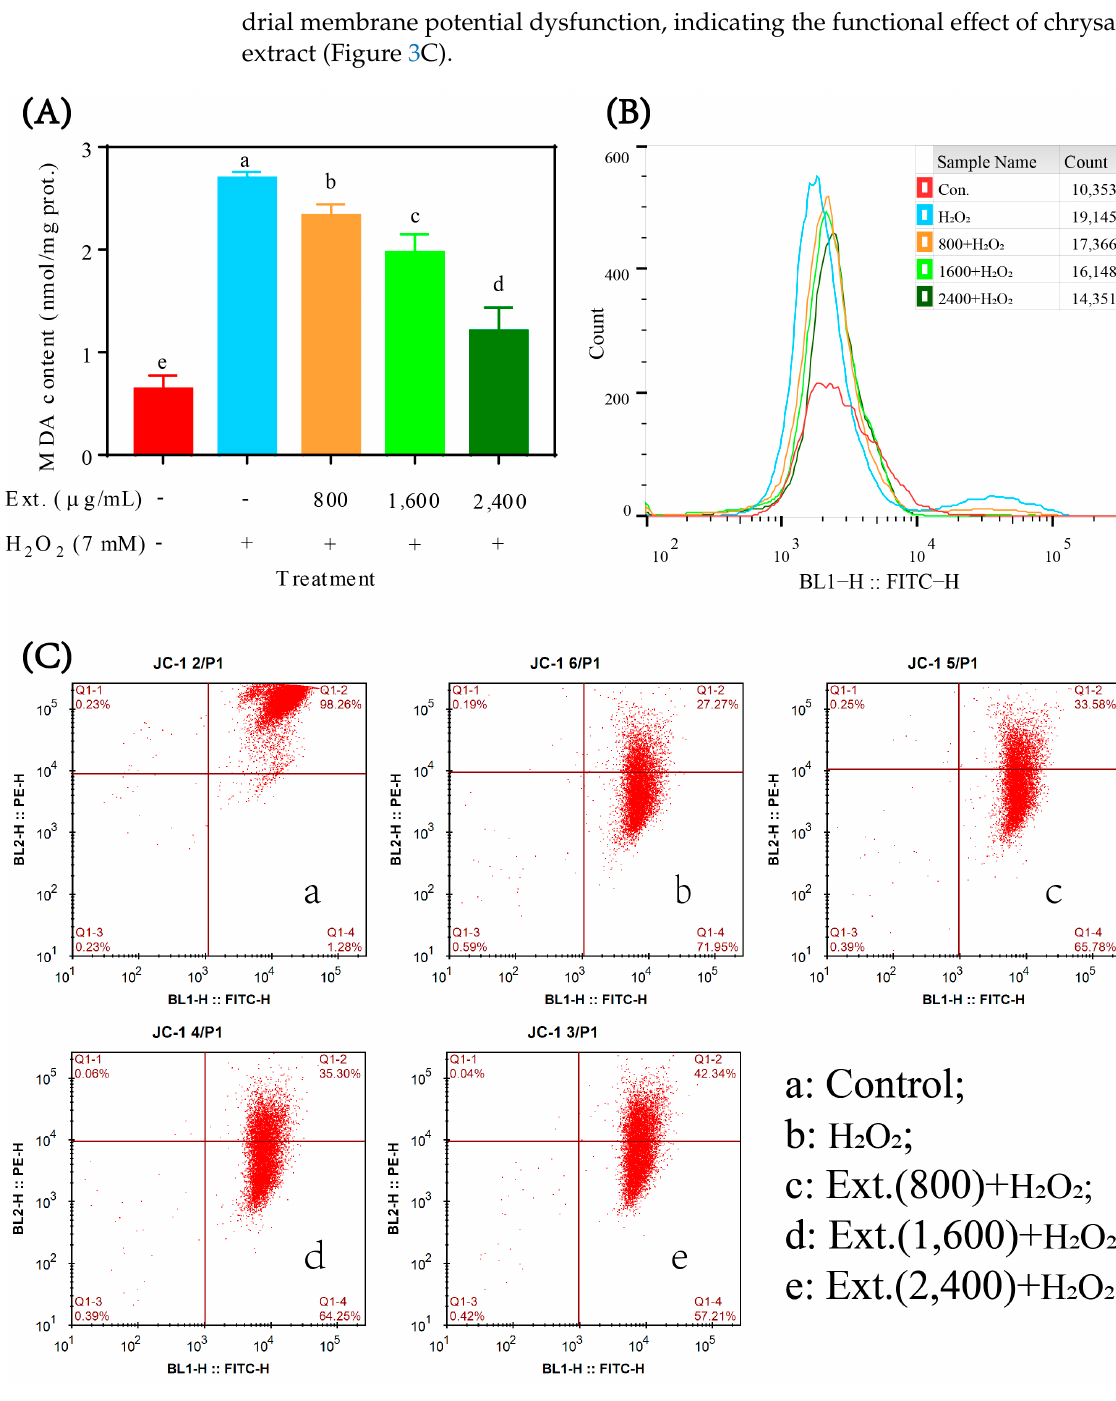
Figure 3. MDA, ROS content and mitochondrial membrane potential. ( A ) TBARS was performed to evaluate the lipid peroxides in L-O2 cells treated with chrysanthemum extract and H 2 O 2 . ( B ) ROS content was measured by DCF staining followed by flow cytometry. A small peak to the right of the main peak indicates a cell population containing high levels of ROS. ( C ) Mitochondrial membrane potential was measured by JC-1 staining followed by flow cytometry. FITC (BL1) indicates monomeric JC1, while red fluorescence (BL2) indicates J − aggregates. Ext.: chrysanthemum extract. The lower case letters in figure ( A ) indicate significant difference at p < 0.05 for different treatments.